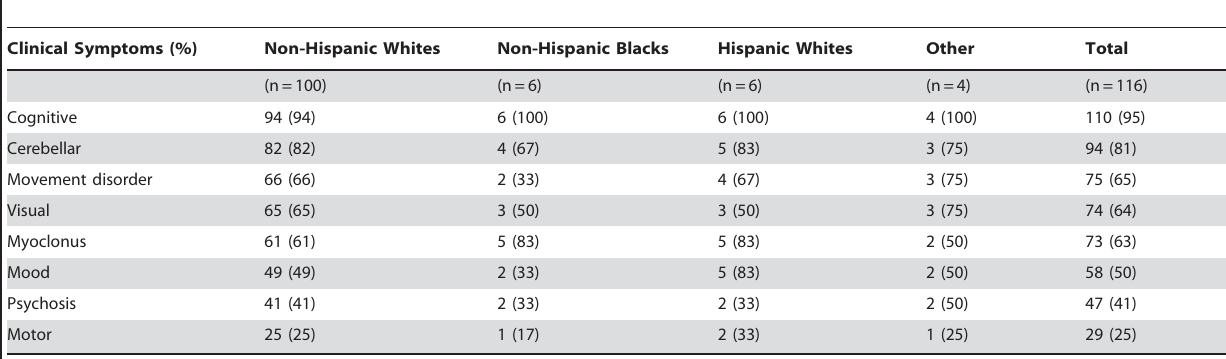
Table 2. Clinical symptoms of subjects throughout the disease course.